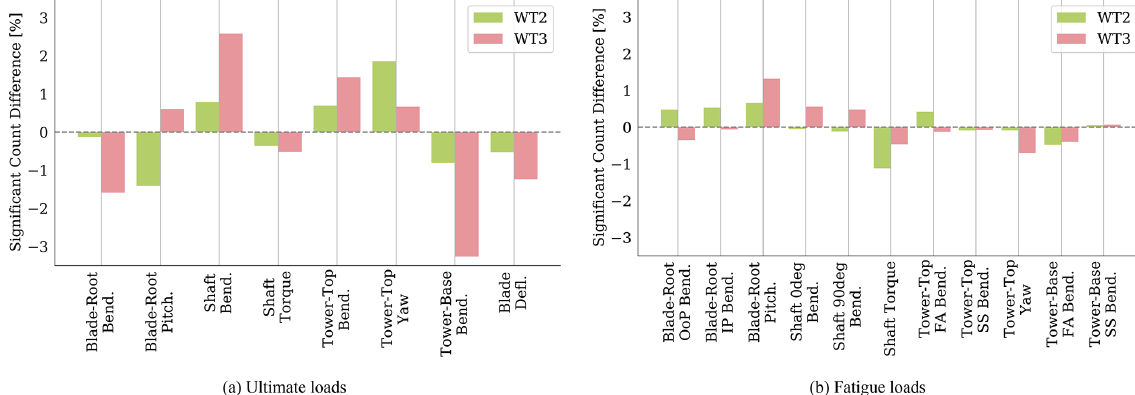
Figure 8. The percent difference in significant event counts for WT2 and WT3 relative to WT1, based on QoI.